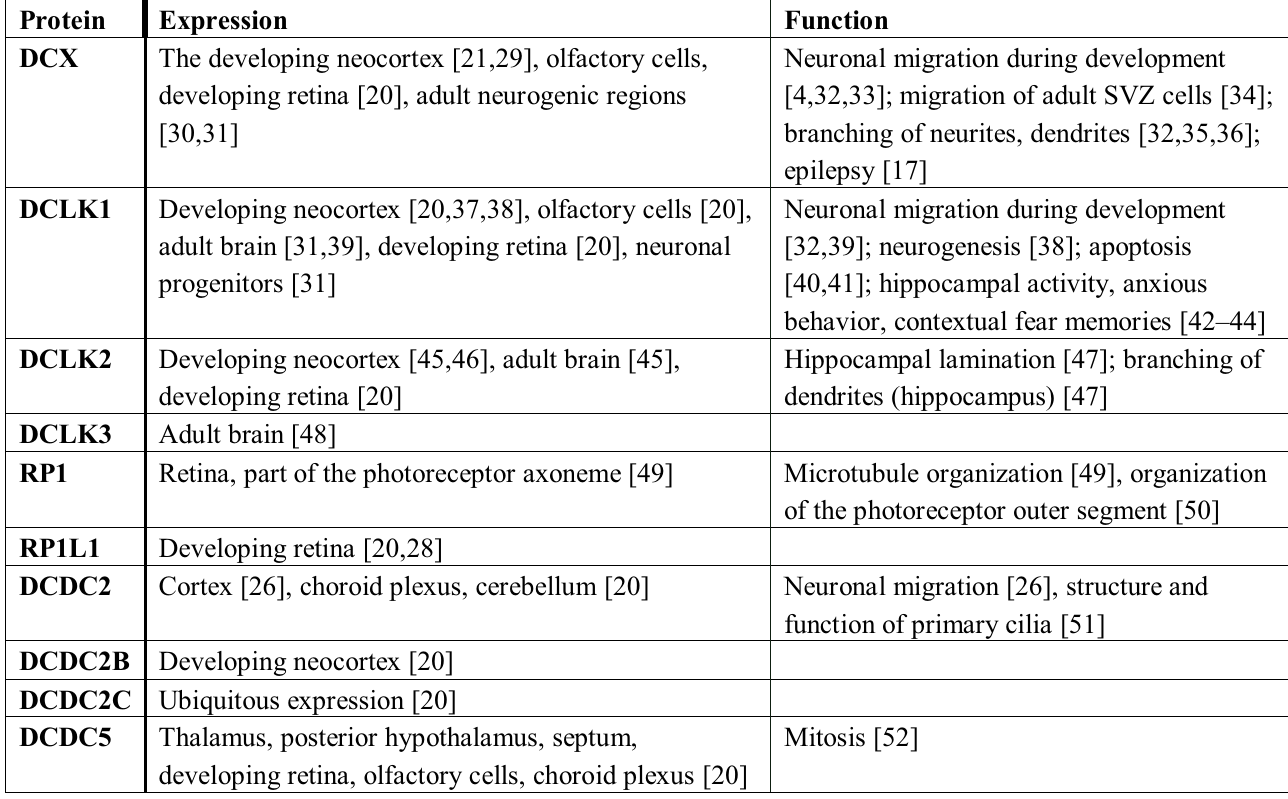
Table 1. The doublecortin superfamily of proteins, expression in the rodent CNS, and putative functions